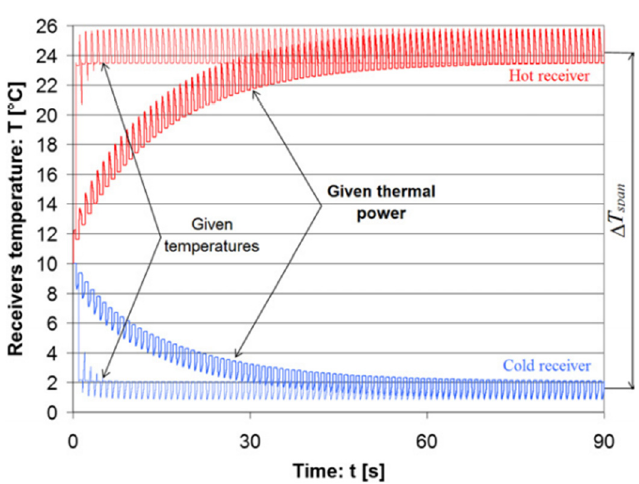
Figure 34. Conceptual scheme of the AMRR model [61].